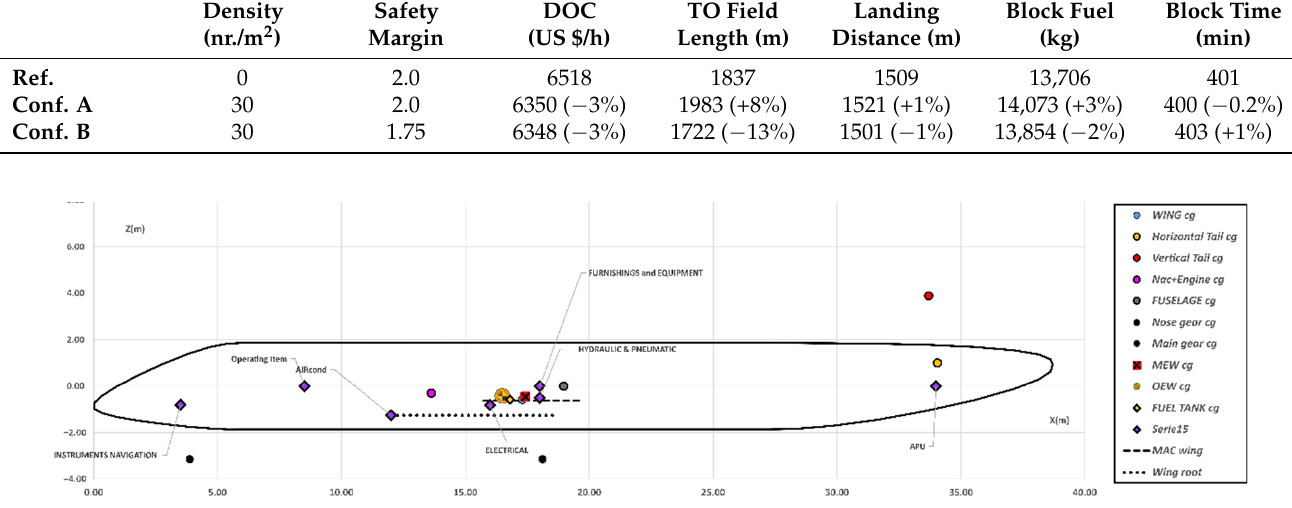
Figure 6. Centre of gravity position of each aircraft component and system.